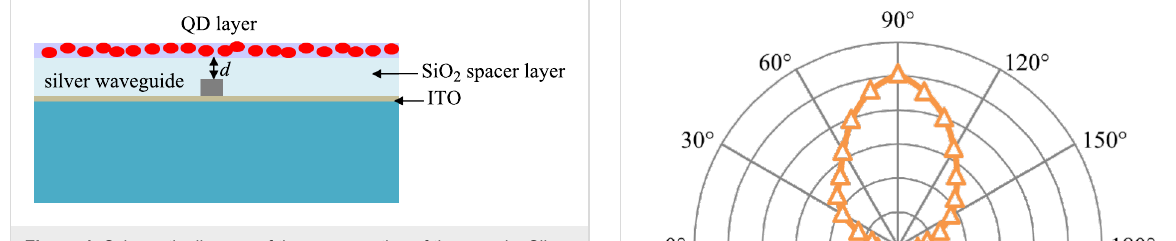
Figure 4: Schematic diagram of the cross section of the sample. Silver stripe waveguide on ITO-coated glass slide. Structures are covered with SiO 2 spacer layer with thickness d . QDs were spin coated on top of SiO 2 .